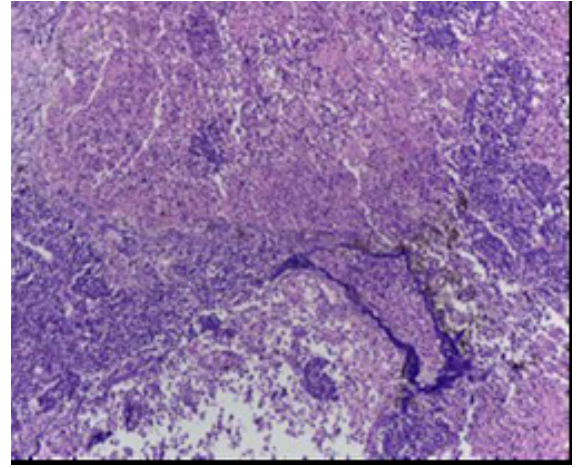
Figure 2. Small cell carcinoma of the lung.